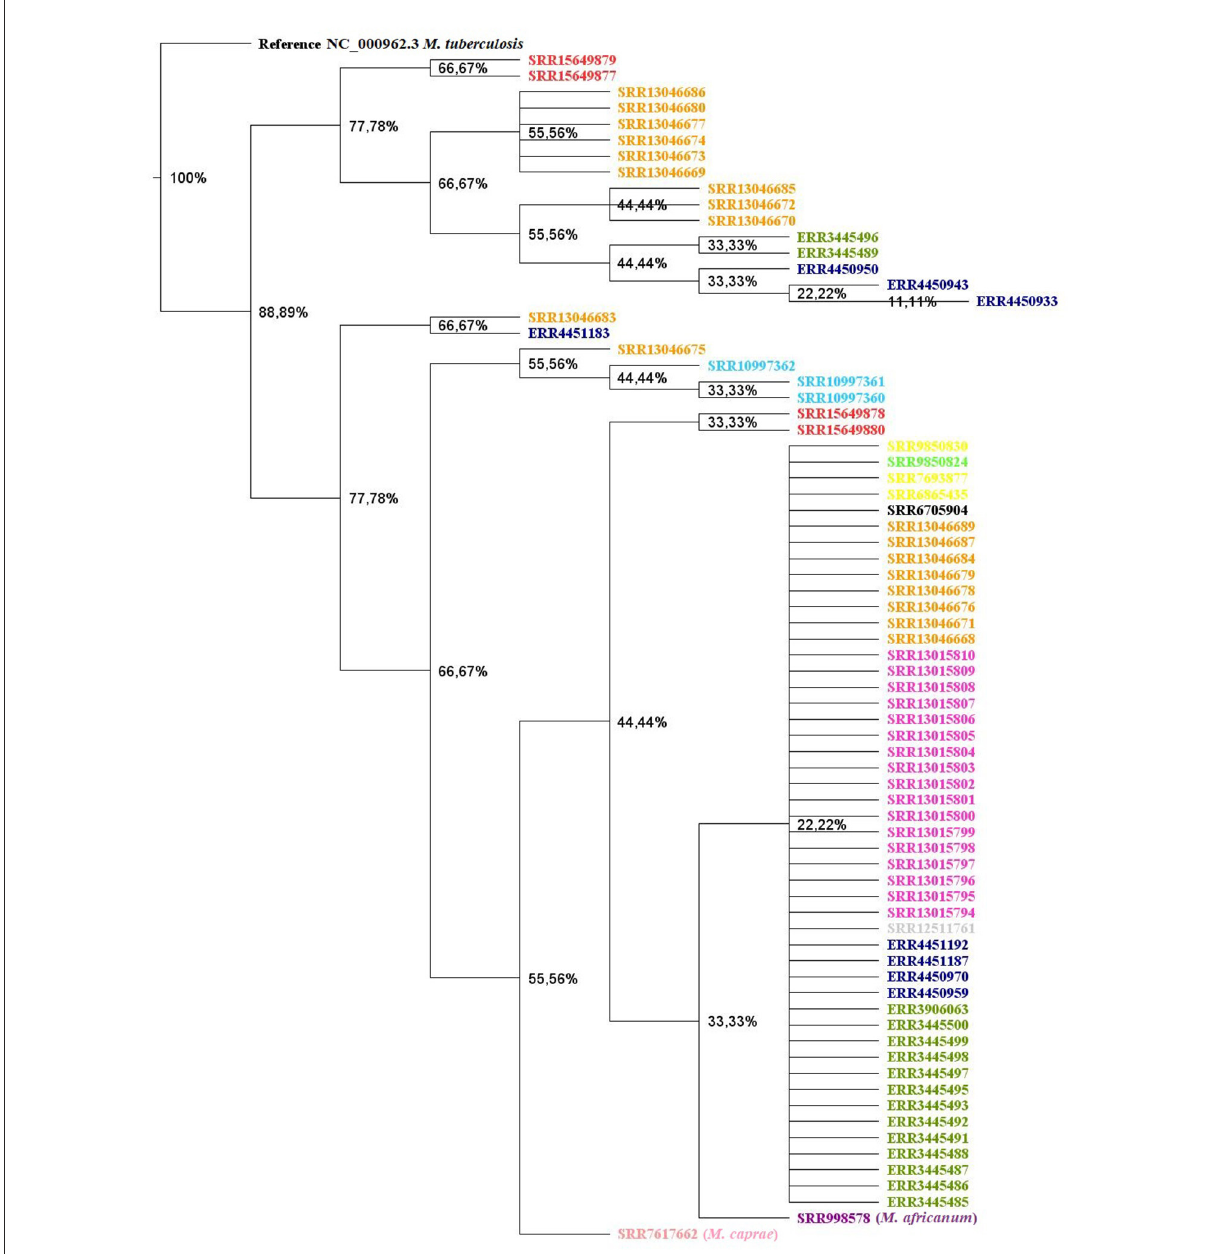
FIGURE2 Maximum likelihood phylogenetic tree of Mycobacterium tuberculosis variant bovis genomes sequenced in the state of Mato Grosso grouped with other genomes sequenced in other states of Brazil. Four Mycobacterium tuberculosis variant bovis genomes isolated from bovine TMT05 (SRR15649880), TMT116 (SRR15649878), TMT24 (SRR15649879), and TMT123 (SRR15649877) from the state of Mato Grosso. Identifications in red : Mycobacterium tuberculosis variant bovis genomes obtained from cattle and sequenced in this study; green : Mycobacterium tuberculosis variant bovis genomes from cattle or buffalo from Marajó Island, Pará; orange : genomes of Mycobacterium tuberculosis variant bovis obtained from cattle or buffaloes from the Amazon; dark blue : Mycobacterium tuberculosis variant bovis genomes obtained from cattle from southern Brazil; pink : Mycobacterium tuberculosis variant bovis genomes obtained from deer from a safari in southern Brazil; yellow : llama; light blue : BCG strain genome; light green : capybara; gray : Mycobacterium tuberculosis variant bovis isolated from cattle; black: first Mycobacterium tuberculosis variant bovis strain sequenced in Brazil; outgroups: Mycobacterium africanum (purple) , Mycobacterium caprae (light pink) , and Mycobacterium tuberculosis (black)